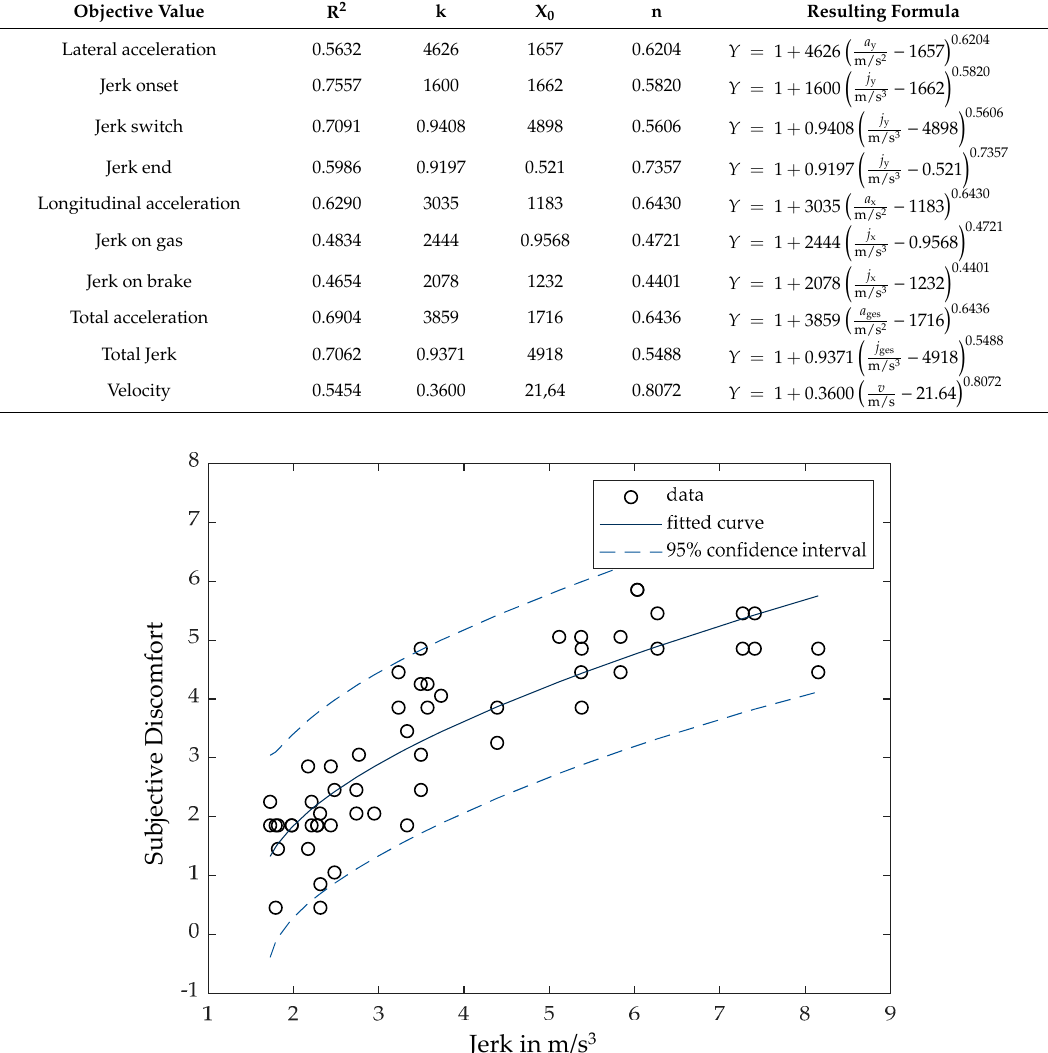
Figure 8. Regression analysis for the objective value jerk onset in Maneuver B.